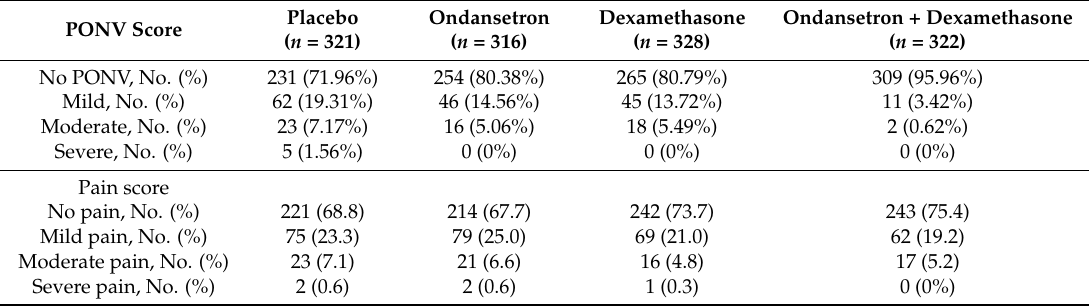
Table 5. Standardized score of postoperative nausea and vomiting (PONV) severity and pain score. Placebo Ondansetron Dexamethasone Ondansetron + Dexamethasone PONV Score ( n = 321) ( n = 316) ( n = 328) ( n = 322) No PONV, No. (%) 231 (71.96%) 254 (80.38%) 265 (80.79%) 309 (95.96%) Mild, No. (%) 62 (19.31%) 46 (14.56%) 45 (13.72%) 11 (3.42%) Moderate, No. (%) 23 (7.17%) 16 (5.06%) 18 (5.49%) 2 (0.62%) Severe, No. (%) 5 (1.56%) 0 (0%) 0 (0%) 0 (0%) Pain score No pain, No. (%) 221 (68.8) 214 (67.7) 242 (73.7) 243 (75.4) Mild pain, No. (%) 75 (23.3) 79 (25.0) 69 (21.0) 62 (19.2) Moderate pain, No. (%) 23 (7.1) 21 (6.6) 16 (4.8) 17 (5.2) Severe pain, No. (%) 2 (0.6) 2 (0.6) 1 (0.3) 0 (0%)